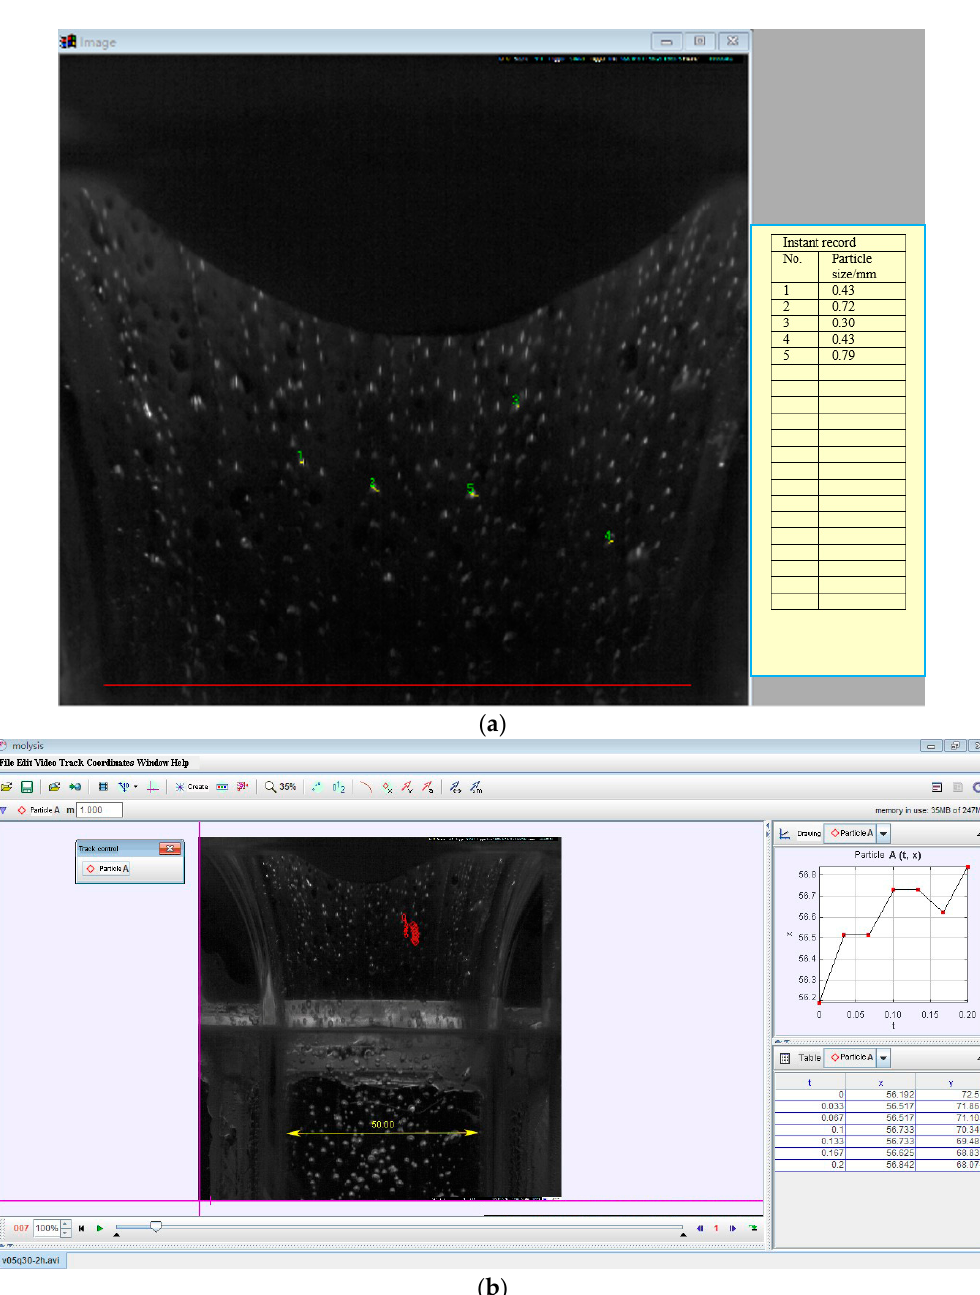
Figure 4. Operating interface of measuring software: ( a ) Nano Measurer; ( b ) Molysis.